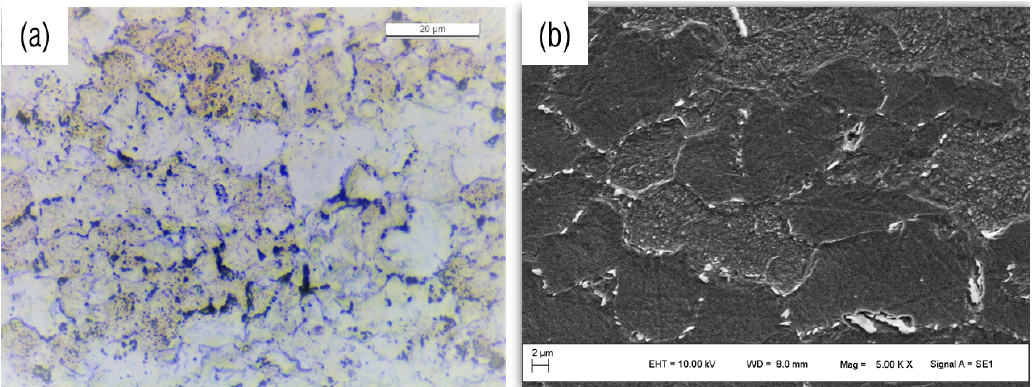
Figure 1. Resulting microstructure of AISI 410 stainless steel after thermal treatments by ( a ) LM 1000 × , and ( b ) SEM 5000 × , after Vilella acid etching.